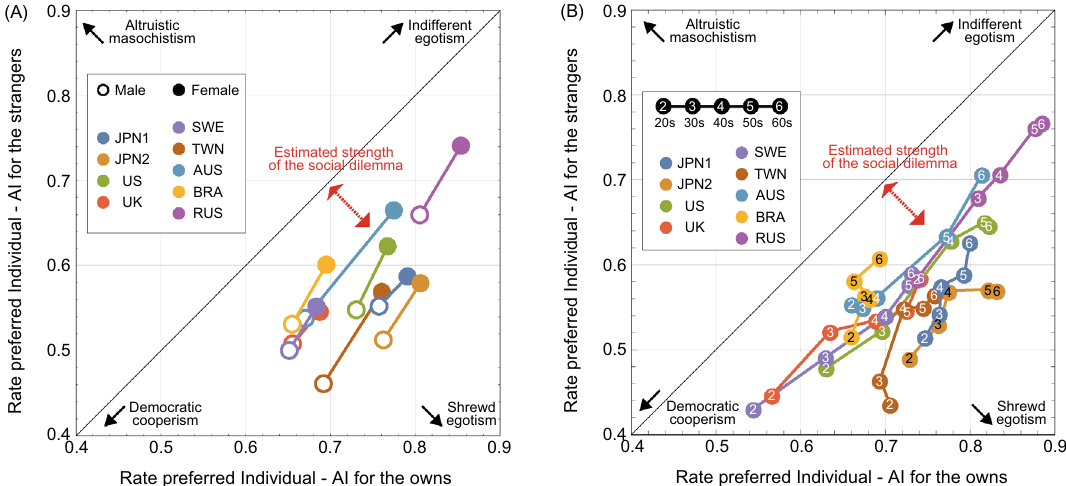
Figure 4. Country/area, gender and age differences in the social dilemma and characteristics of the responses. Scatterplot of the proportion of the sample who chose the Individual-AI diagnosis over the World-AI diagnosis. The horizontal axis is the portion of the sample who preferred Individual-AI to diagnosis themselves, and the vertical axis is that for strangers. The upper-right region is an individualistic response in which the respondents preferred the Individual-AI diagnosis for both themselves and strangers. In contrast, the lower-left region is an institutionalized response in which the respondents preferred the World-AI diagnosis when either themselves or strangers get sick. The lower-right region below the diagonal indicates that the respondents’ preference for the Individual-AI diagnosis was higher for themselves than for strangers. The distance between the diagonal and the plot shows the estimated strength of the social dilemma. ( A ) Gender differences in all eight countries/areas and ( B ) age group differences in all eight countries/areas. The absence of plots in the upper left region means that the respondents judged their own lives to be more important than those of strangers in